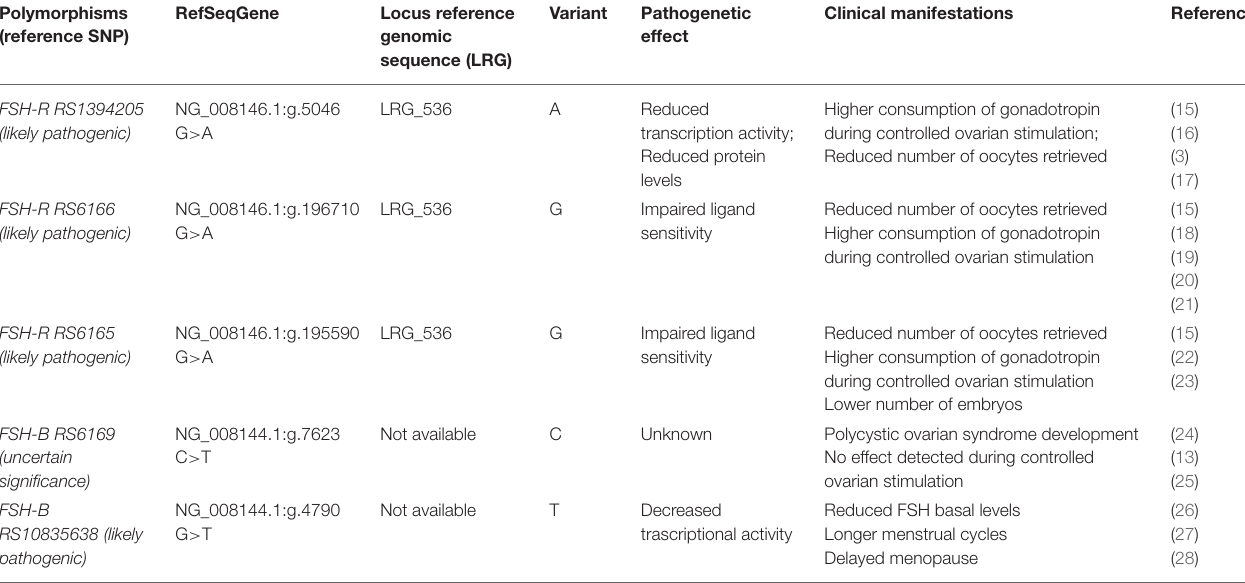
TABLE 1 | Clinical manifestations and pathogenetic effects of FSH-R and FSH-B subunit most common variants (https://www.ncbi.nlm.nih.gov/snp). Polymorphisms (reference